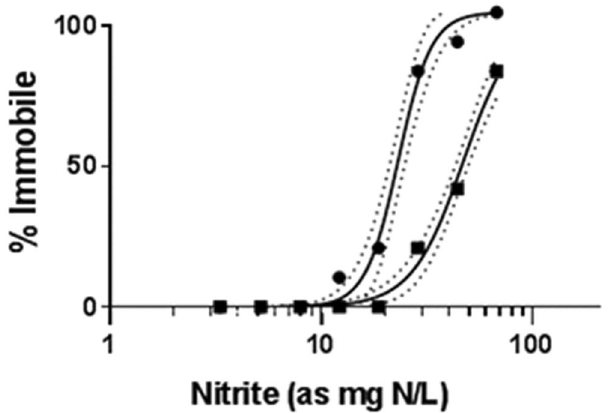
Figure 4. Concentration-response of D . magna reared in the absence (circles) and presence (squares) of 3.0 nM pyriproxyfen for 48 hours prior to exposure to various concentrations of sodium nitrite. Data points are presented as the percentage immobilized daphnids (n = 10) at each concentration of NaNO 2 . Confidence intervals (95%) are depicted by dotted lines.